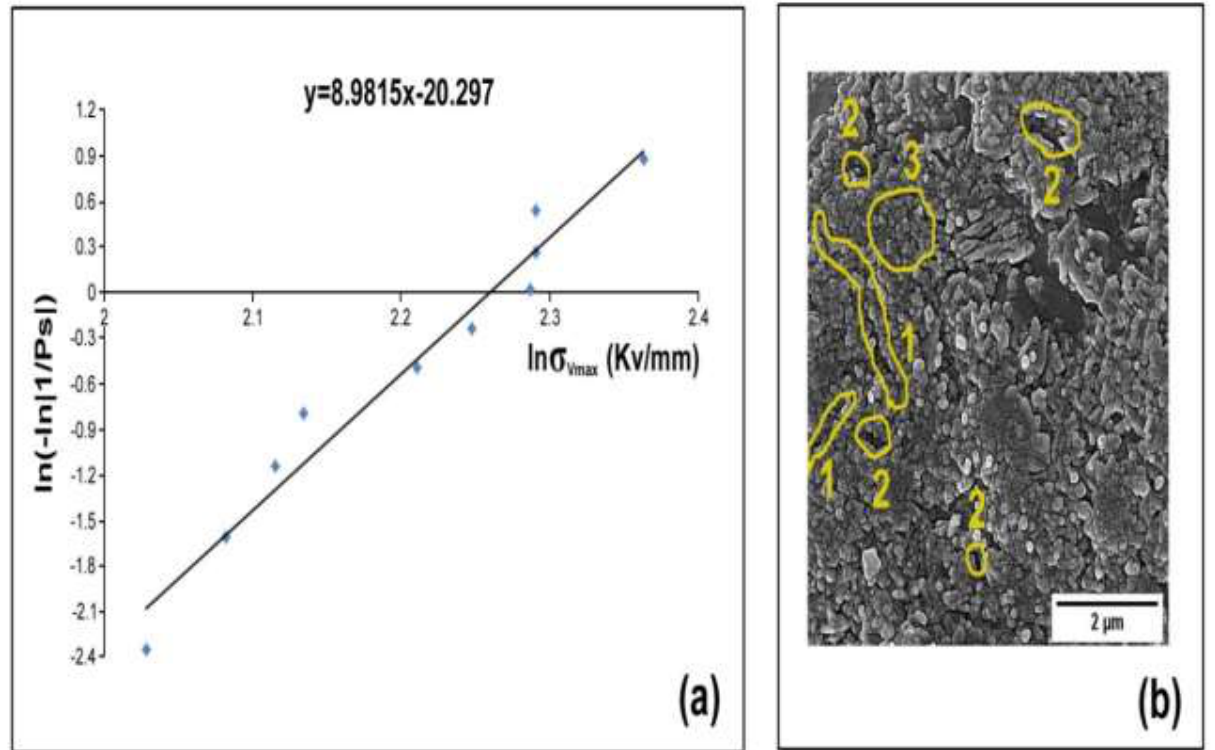
Figure 2: (a) Weibull modulus determination for LC1S as homogeneity indicator. (b) FESEM image for LC1S microstructure 2